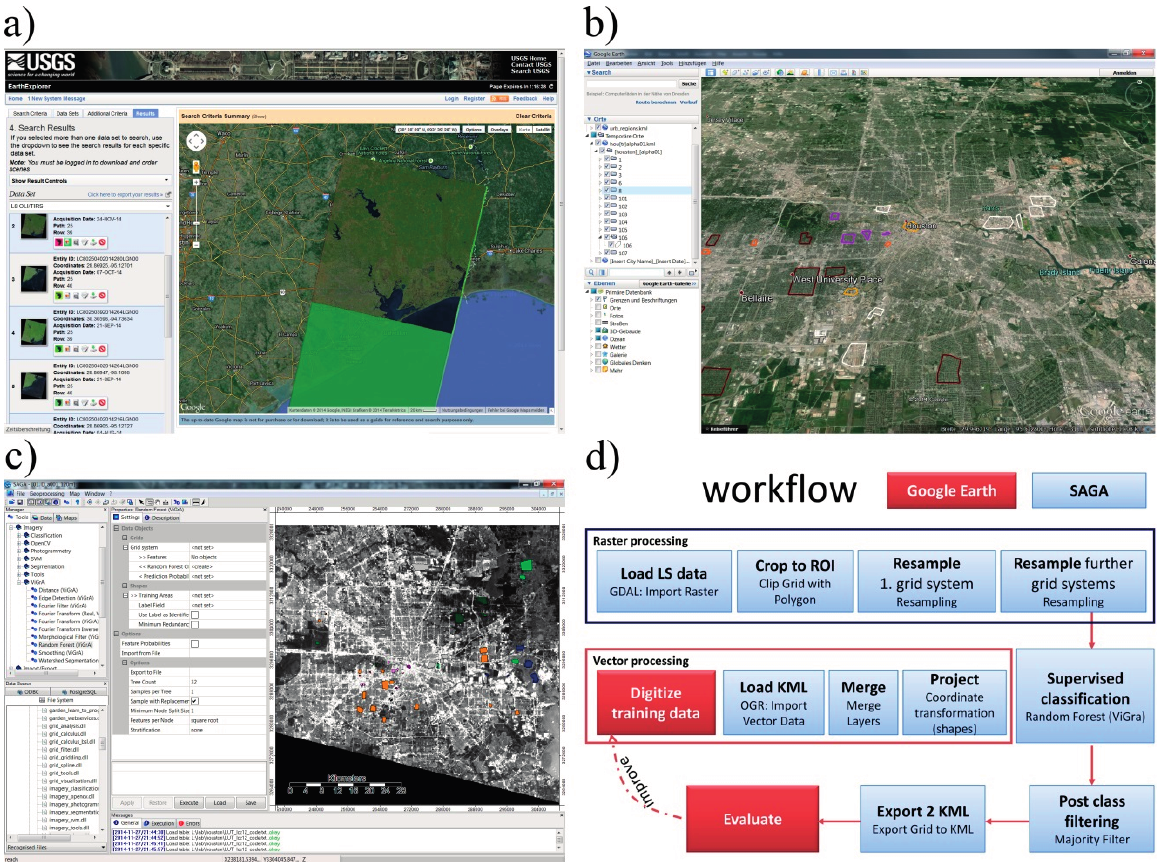
Figure 5. Overview of the mapping procedure. ( a ) Acquisition of Landsat data in USGS Earth-Explorer; ( b ) digitization of training areas in Google Earth; ( c ) classification in SAGA-GIS; ( d )